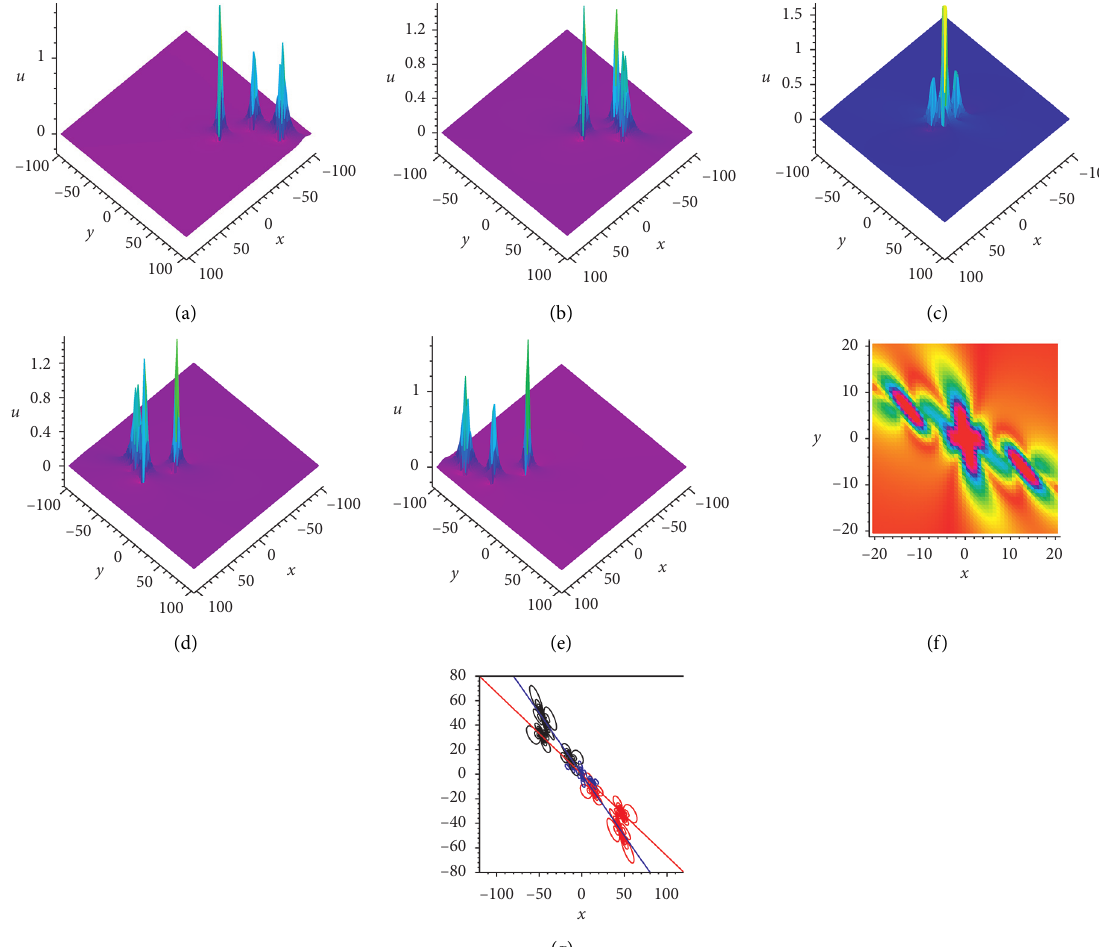
Figure 6: Evolution graphs of the third-order lump solution: (a), (b), and (c) three-dimensional plots at t � − 40, t � − 25, and t � 0, (d), (e), and (f) density plots at t � 25, t � 40, and t � 0, and (g) the contour plot at t � − 25 (black), t � 0 (blue) and t � 25 (red) about moving path described by the blue line y � − x and red line y � − ( 2/3 ) x .